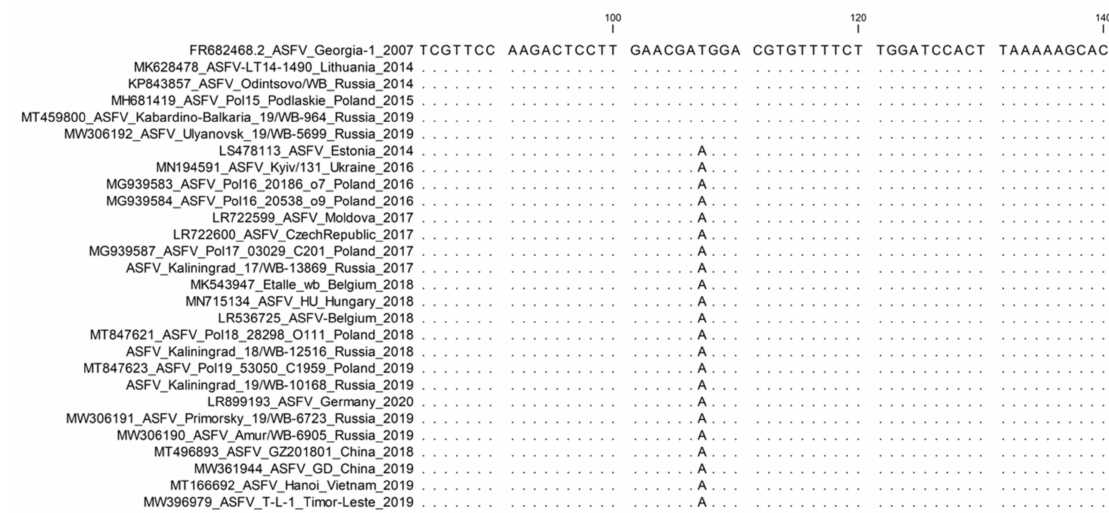
Figure 9. Nucleotide sequence alignment of ASFV samples using the partial ORF I267L gene. Samples from Poland, China, and the east of Russia contain an “A,” whilst the reference sequence Georgia 2007/1 and the western region of the RF contain a